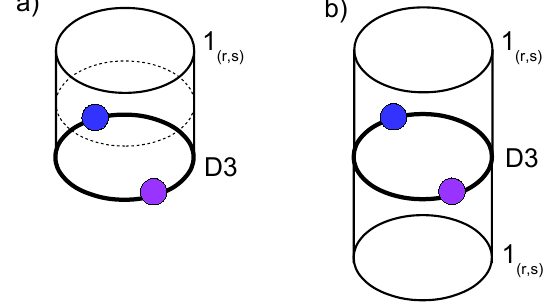
Figure 33 . (a) Brane setup with a semi 1 r;s string ending on the D3 from above, inserting the monopole operator V + . (b) Setup with a full 1 ( r;s ) ( X 1 ) j s j ( X 2 ) j s (cid:0) (cid:20)r j . The vertical direction is that spanned by the 1